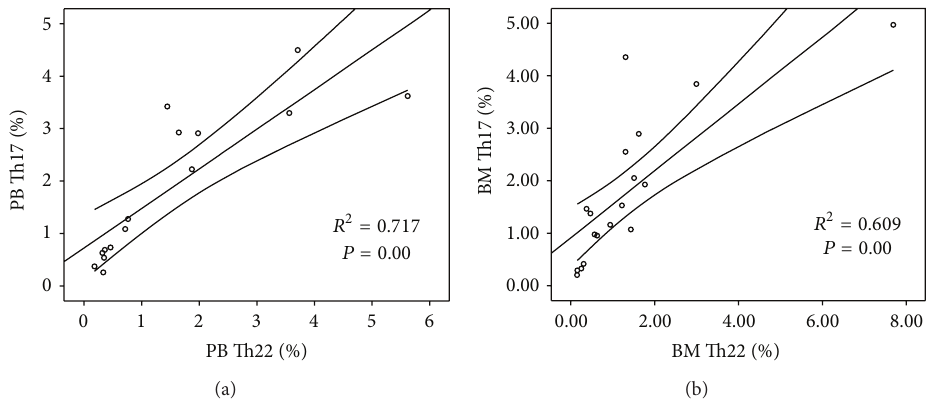
Figure 5: Correlation between the percentages of Th22 and Th17 cells in CML Patients. (a) Positive correlation was found between Th22 cells and Th17 cells in PB of CML patients. (b) Positive correlation was found between Th22 cells and Th17 cells in BM of CML